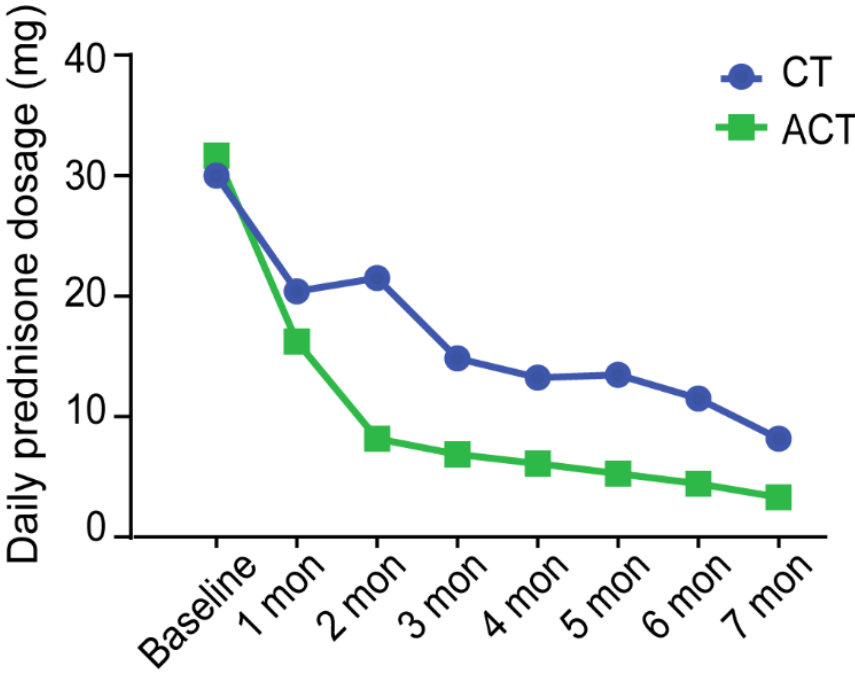
Figure 3. Variation in daily oral prednisone dosage per patient in the ACT (adalimumab plus conventional therapy) group and in the CT (conventional therapy) group during treatment.